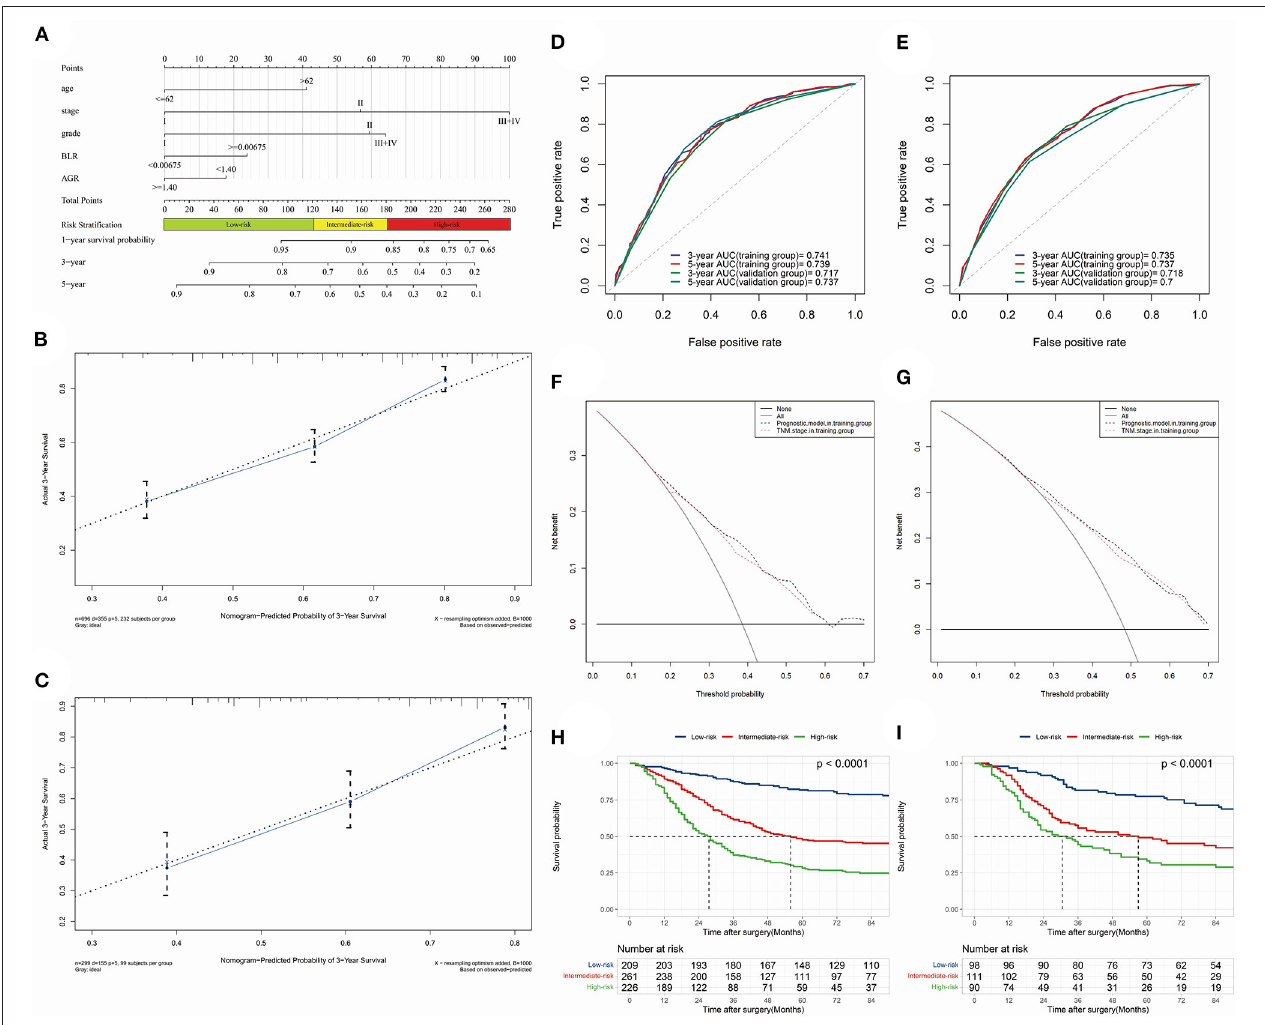
FIGURE 5 | The optimal prognostic model constructed by training group and time-dependent validations. (A) nomogram predicting 1-, 3- and 5-year survival probability with risk stratification; (B) (training group) and (C) (validation group), 3-year calibration plot; (D) (OS) and (E) (PFS), 3- and 5-year receiver operating characteristic (ROC) curves and area under curves (AUC); (F) (3-year) and (G) (5-year), time-dependent decision curve analysis (DCA); (H) (training group) and (I) (validation group), Kaplan-Meier analysis and log-rank test indicating prognostic stratification of high-, intermediate- and